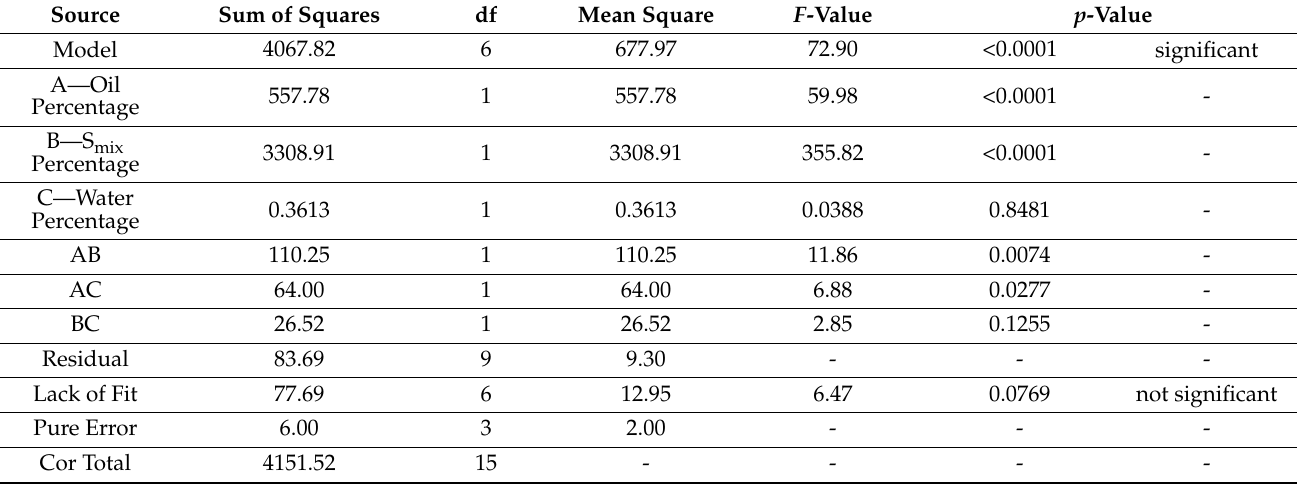
Table 4. ANOVA data for PS of ETB-NE